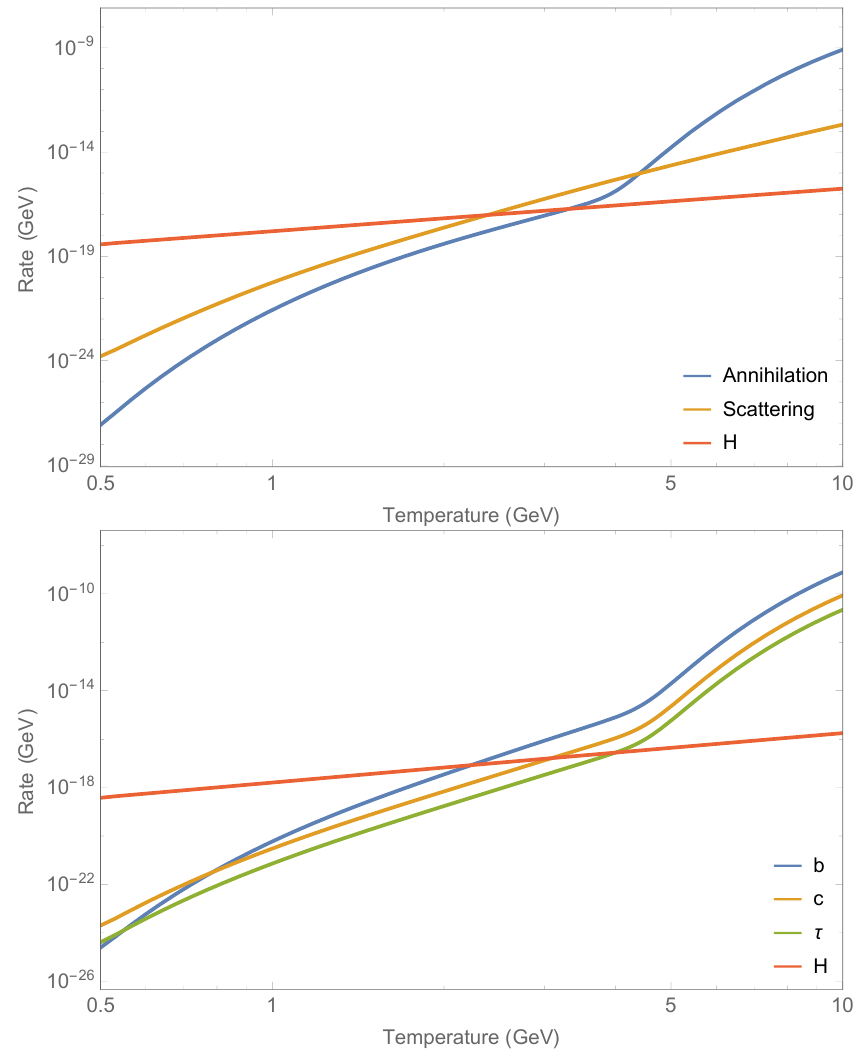
dq in ) decomposed dt 3 s t ^ T